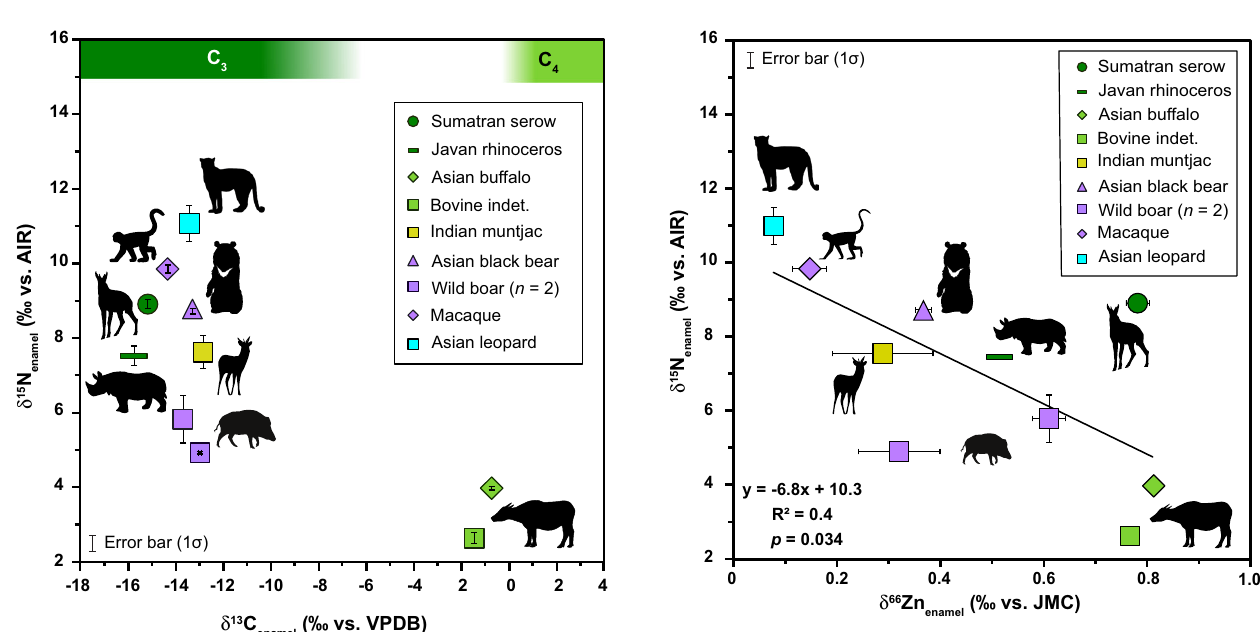
Fig. 6 Regression of paired δ 15 N enamel (this study) versus δ 66 Zn enamel (from Bourgon et al. 40 ) values for the Late Pleistocene fossil teeth from -- x ± 1 σ ; n = 10). The black line indicates the regression Tam Hay Marklot ( for all fossils, and the equation for the regression, R 2 value, and p value are indicated in the upper right of the fi gure. The two trophic level proxies are negatively correlated, as